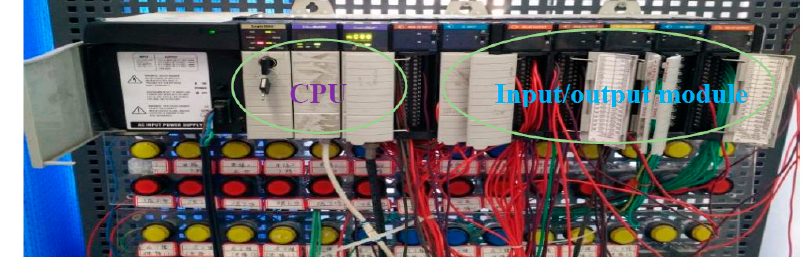
Figure 13. PLC wiring diagram.